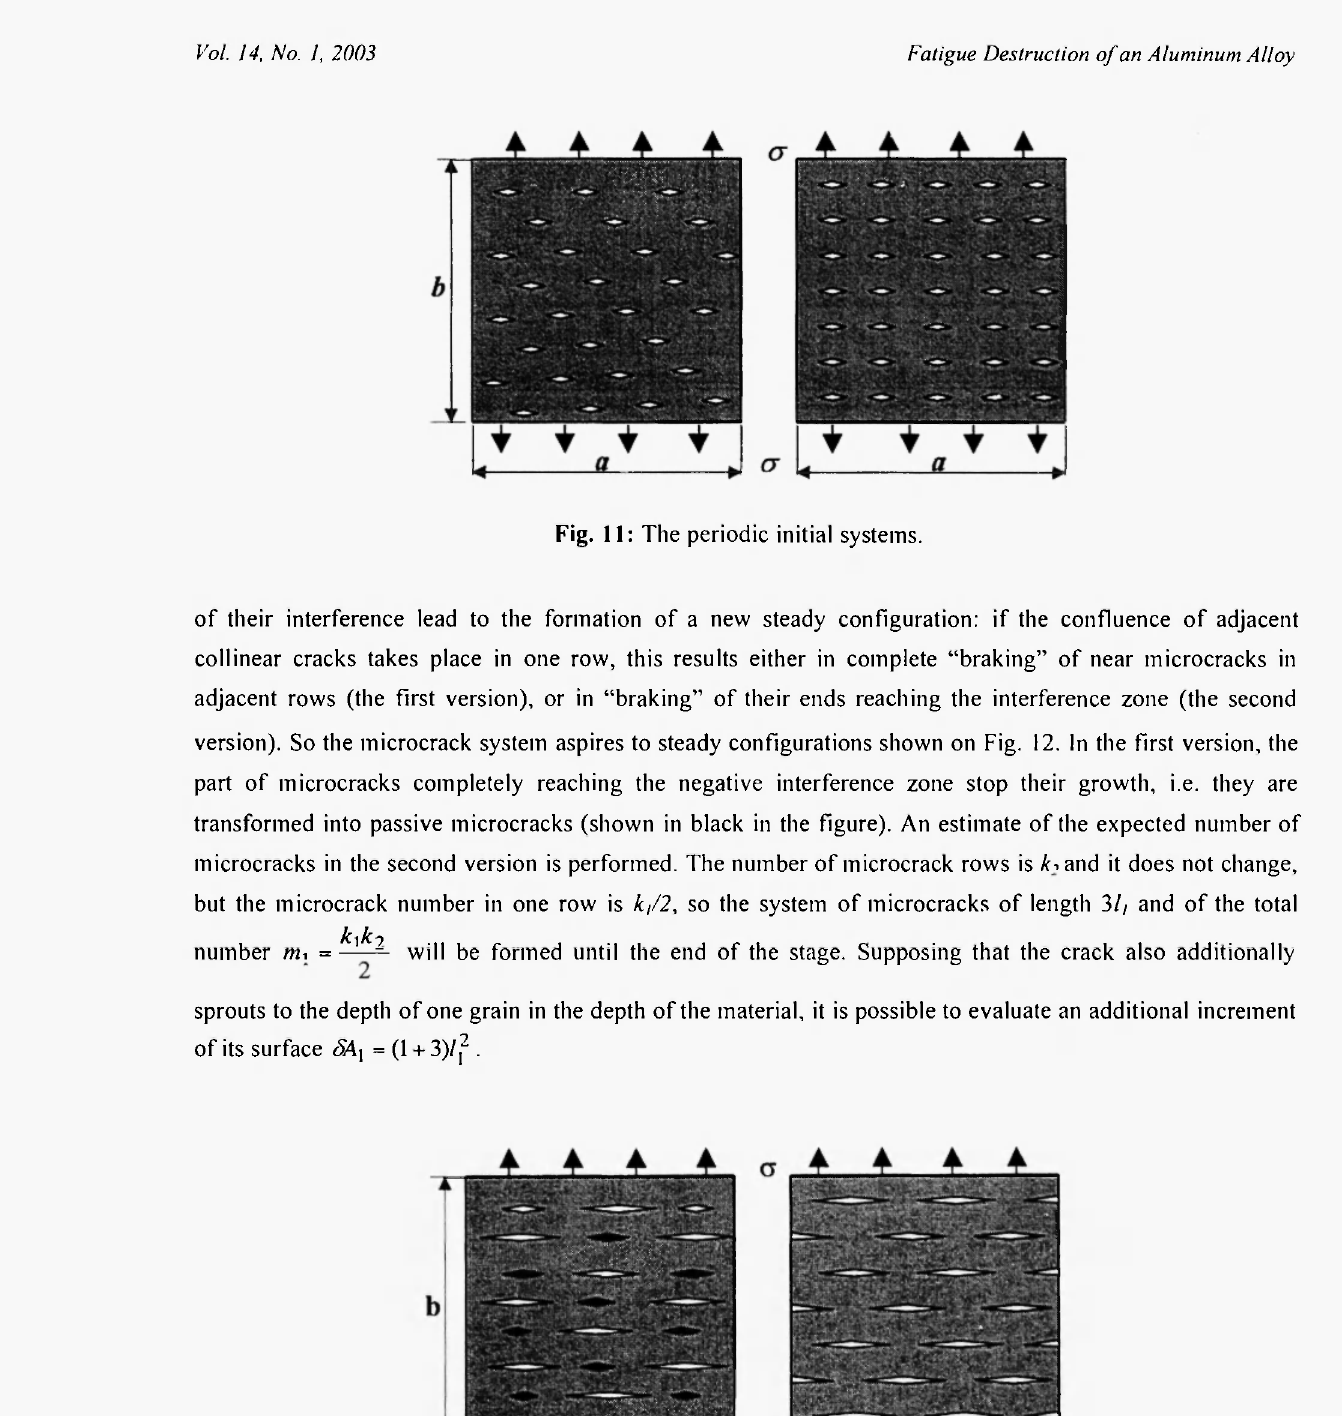
Fig. 12: The microcrack system aspires to steady